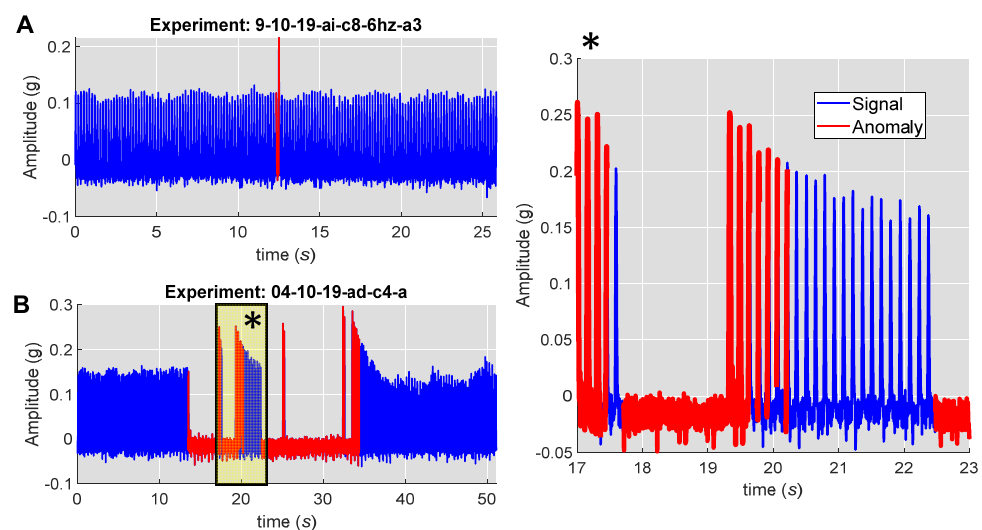
Figure 12. Anomalies detected in experimental signals. ( A ) Left atrium. ( B ) Right atrium. The asterisk (*) indicates a zoom into figure. The triangle indicates the anomaly location.